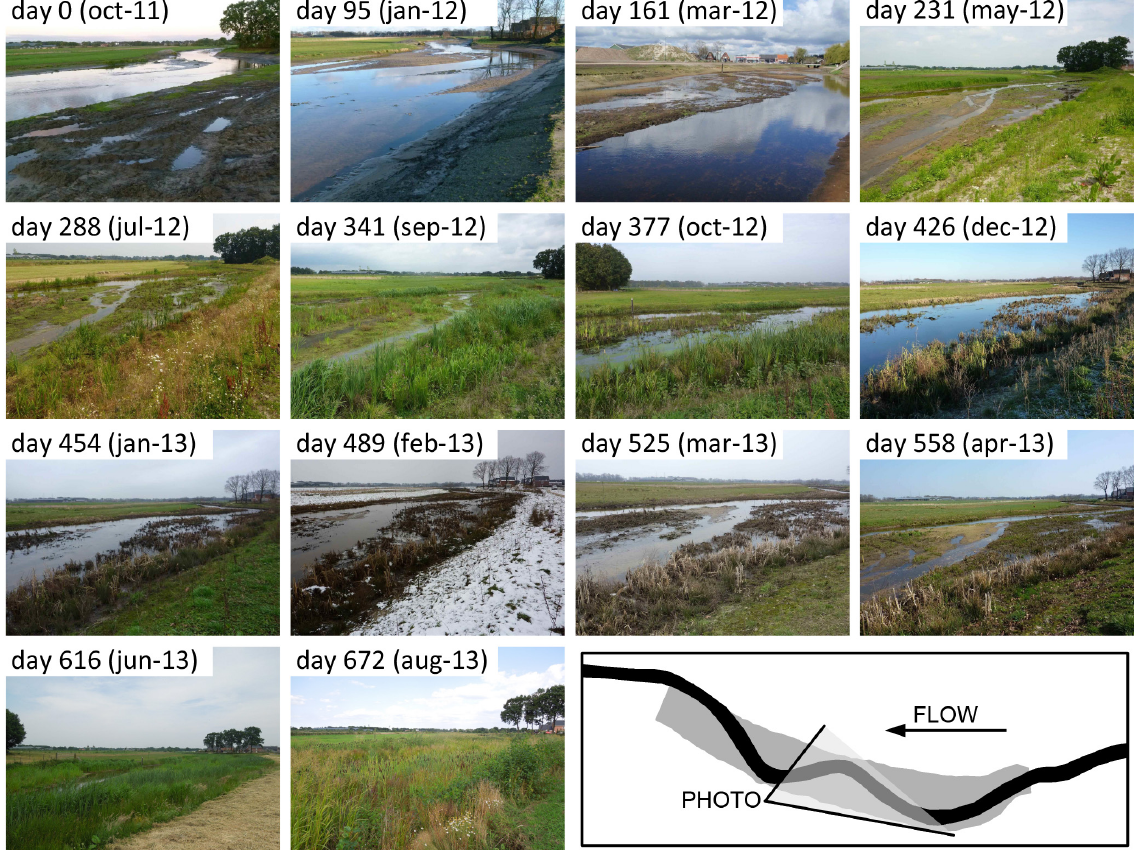
Figure 9. Series of 14 oblique terrestrial photographs taken from the location indicated in Fig. 1d, except for the third photo (day 161), which was taken from the other side of the floodplain.